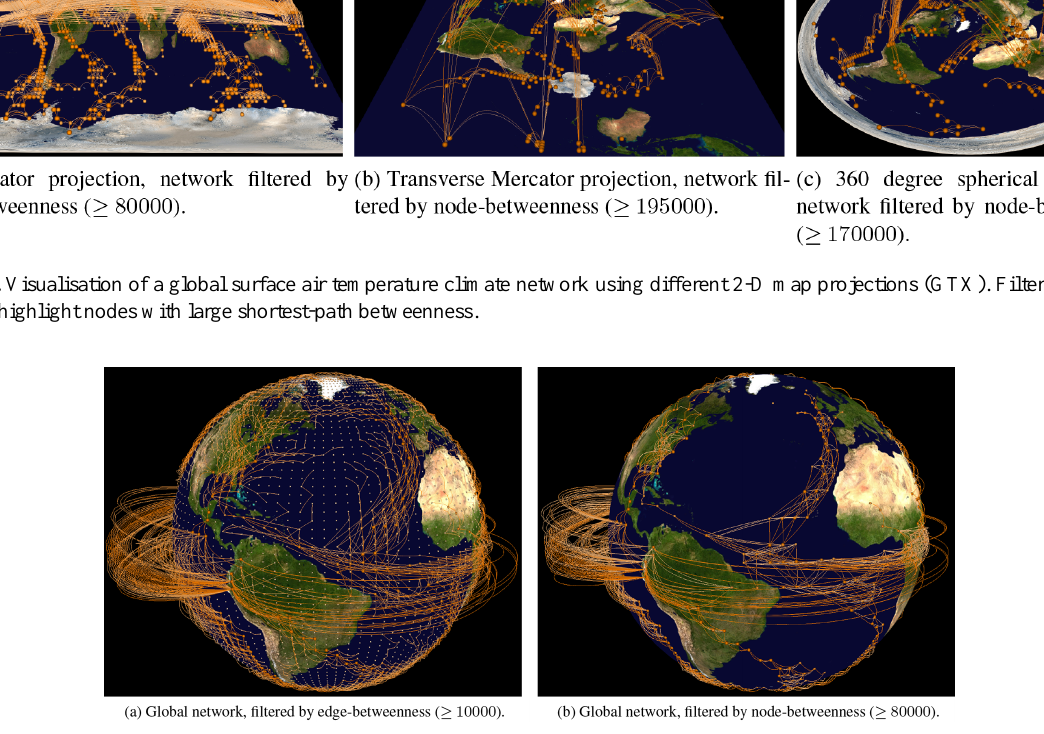
Figure 16. Visualisation of a global surface air temperature climate network embedded on the surface of a 3-D virtual planet using two different filtering criteria